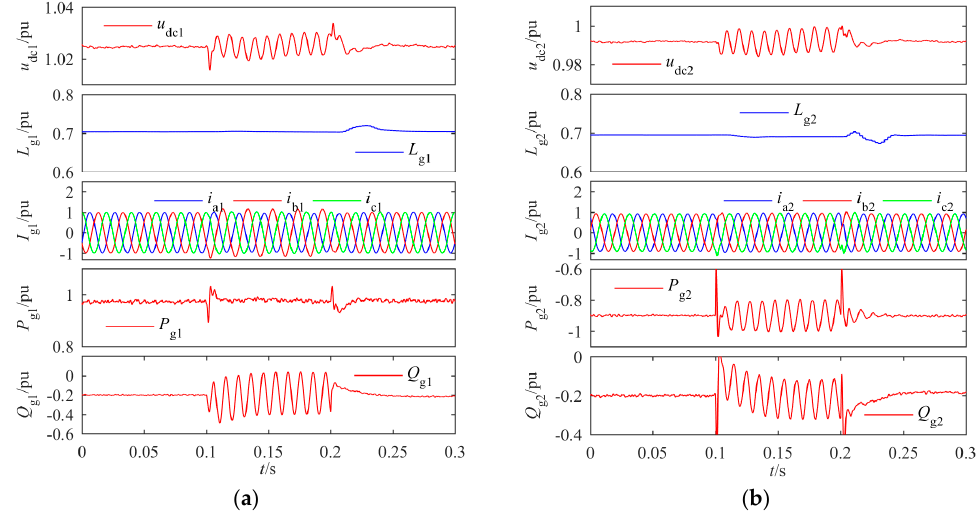
Figure 12. Responses of CS1 ( a ) and CS2 ( b ) to the SOC with the function of the PIDR-SMCC-OIE controller for OBJ 1 and OBJ 3 respectively.